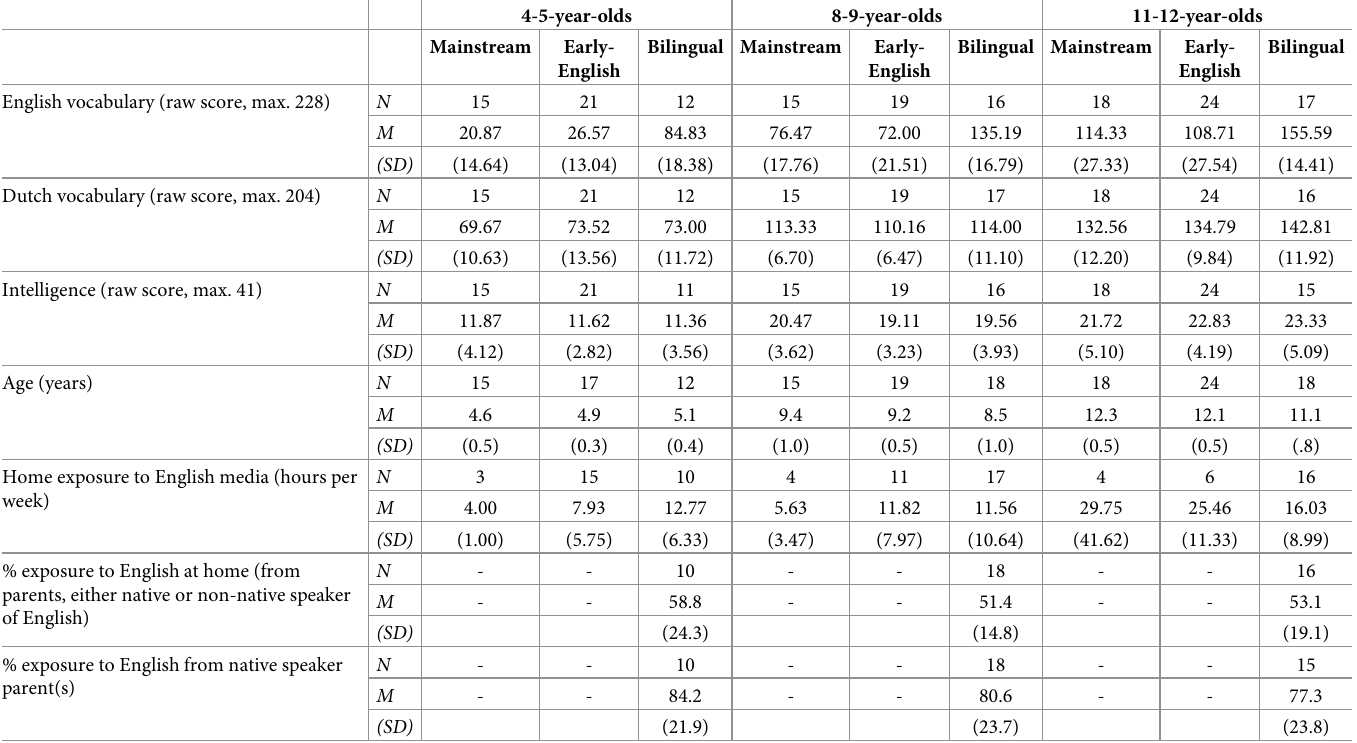
Table 2. Age and scores on all measures, for each type of English acquisition